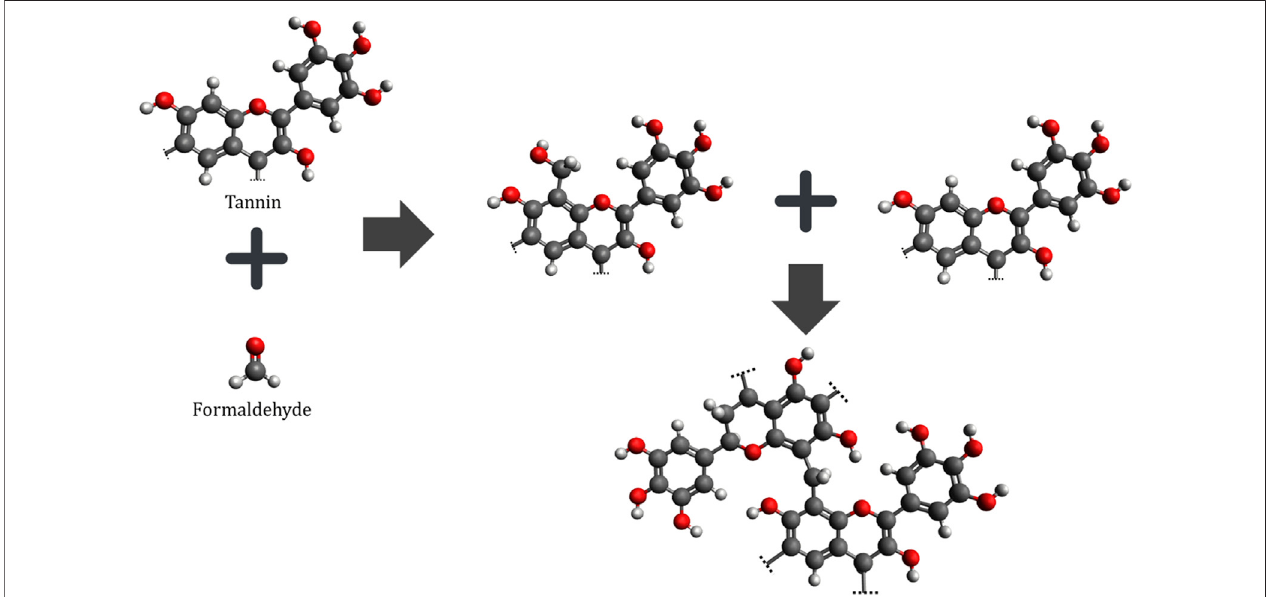
FIGURE 3 | Reaction mechanism between fl avonoid units of tannin and